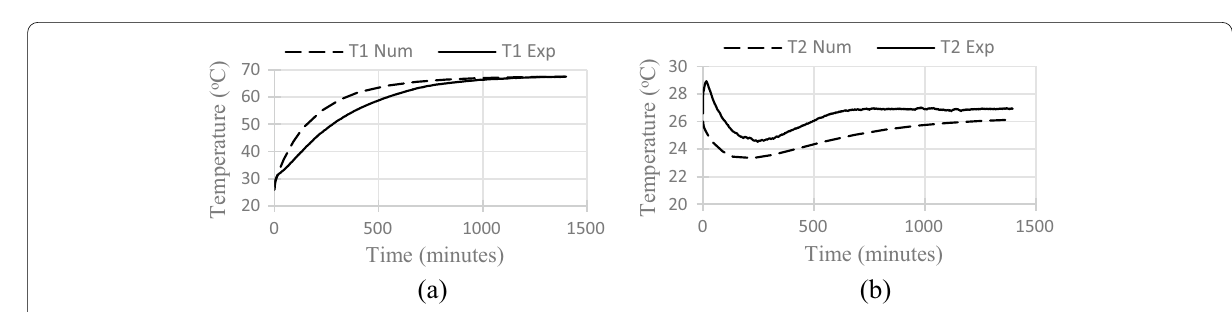
Fig. 11 Experimental and numerical temperature profiles for panel P3 a cold and b hot surfaces.